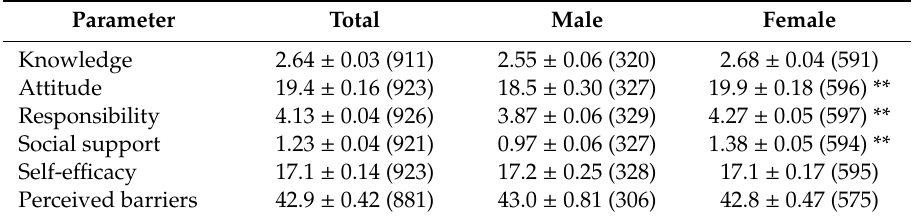
Table 2. Mean scores of psycho-social determinants for fruit and vegetable intakes by gender.